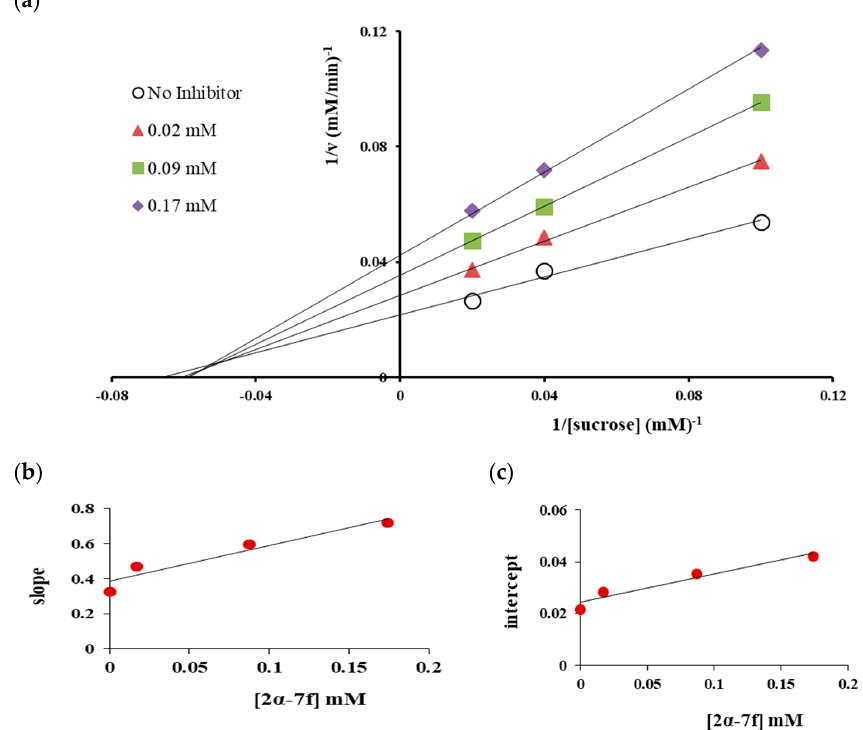
Figure 10. Lineweaver–Burk plots for inhibitory activity of 2 α -7f against rat intestinal sucrase ( a ). Secondary replots of ( b ) slope vs. [I] and ( c ) intercept vs. [I] from a primary Lineweaver–Burk plot for the determination of K i and K’ i ,